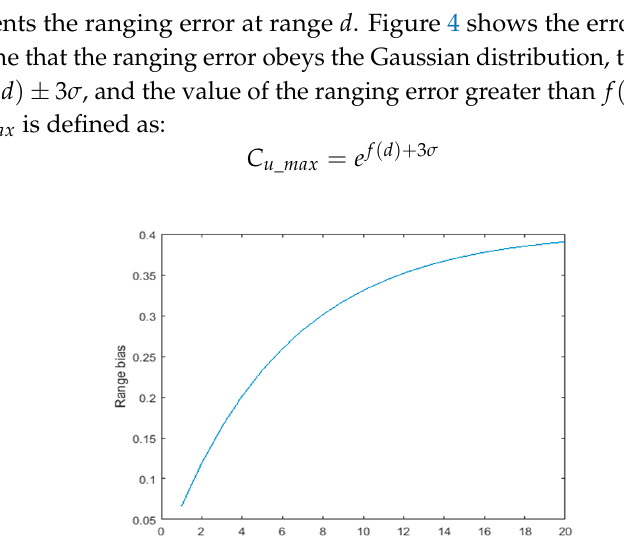
Figure 3. Position estimation by trilateration with measurement error. The robustness factor of the UWB data is defined as: (cid:1829) (cid:3048)(cid:3036) = (cid:4682) (cid:1857) |(cid:3057)(cid:3045) (cid:3284) |